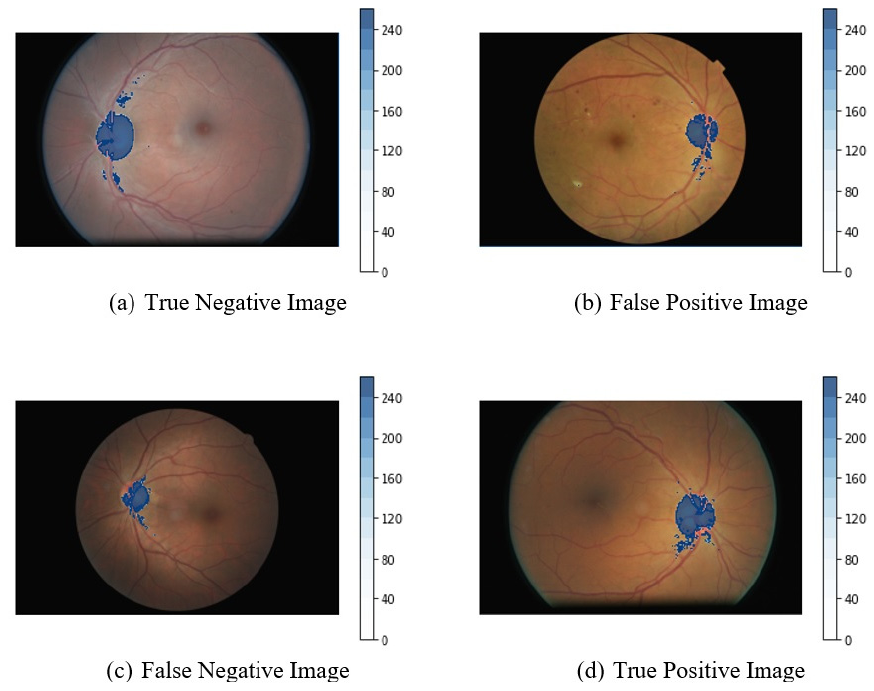
Figure 5. Heat map obtained from last convolution layer are imposed on original image.